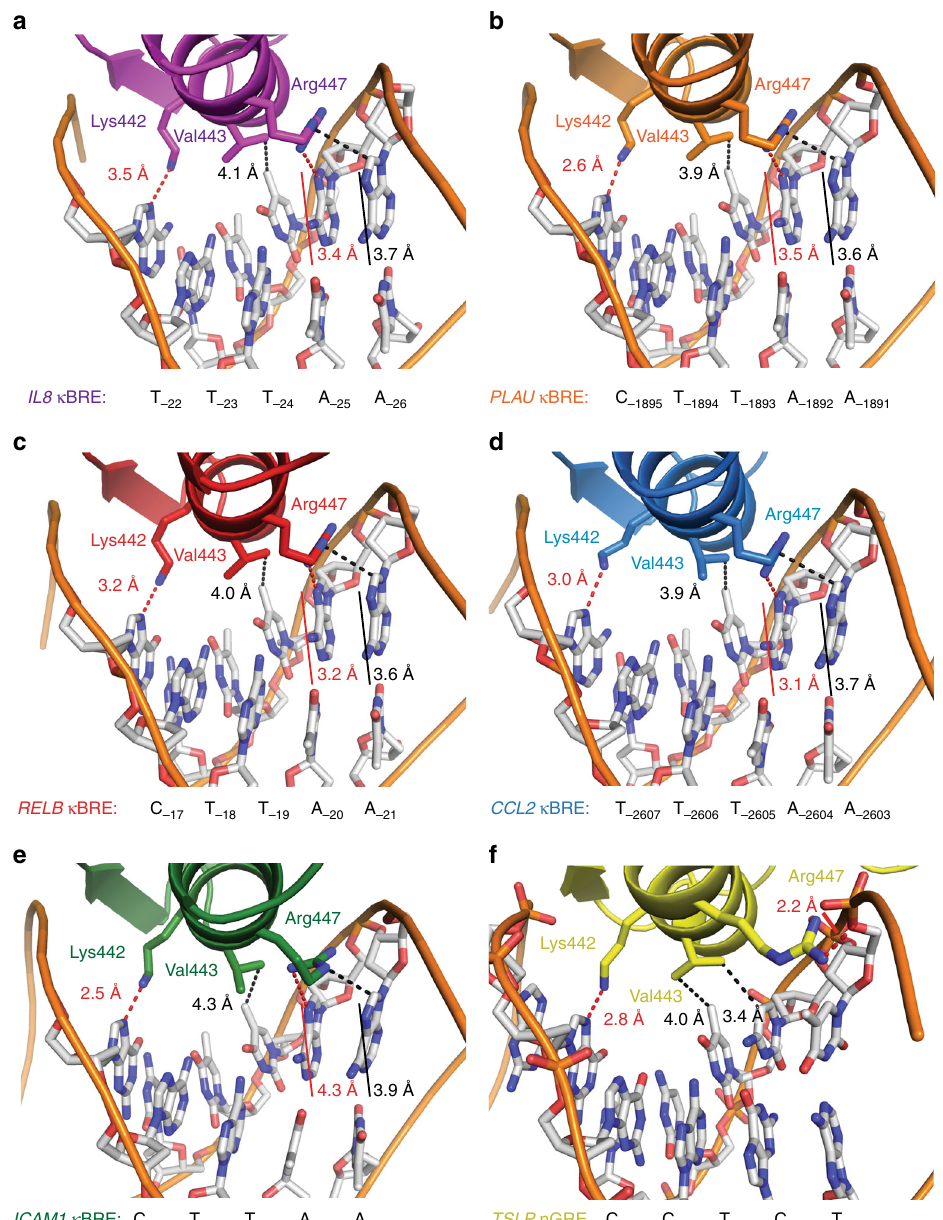
Fig. 4 The GR DBD makes sequence-speci fi c contacts with NF- κ B response elements. a – e Sequence-speci fi c contacts between the GR DBD and the CCL2 , IL8 , PLAU , RELB , and ICAM1 NF- κ B response elements. For comparison, sequence-speci fi c contacts between the GR DBD and the TSLP nGRE are shown in